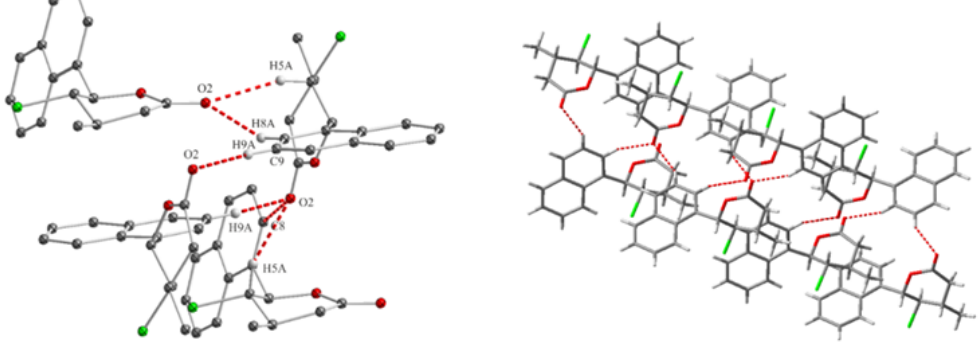
Figure 8. The arrangement of 5a in the unit cell